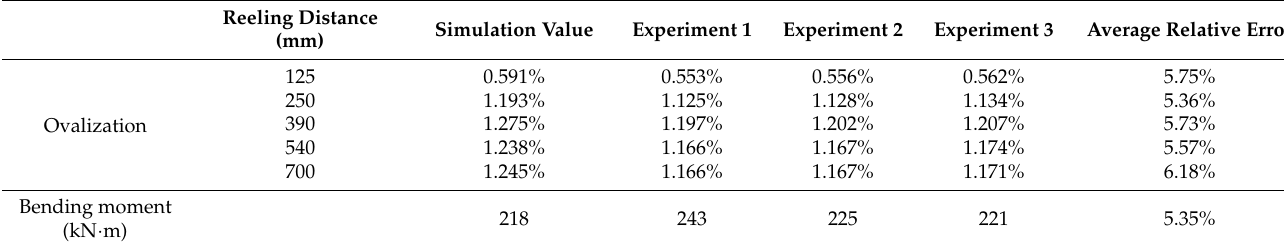
Table 2. Comparison of results.